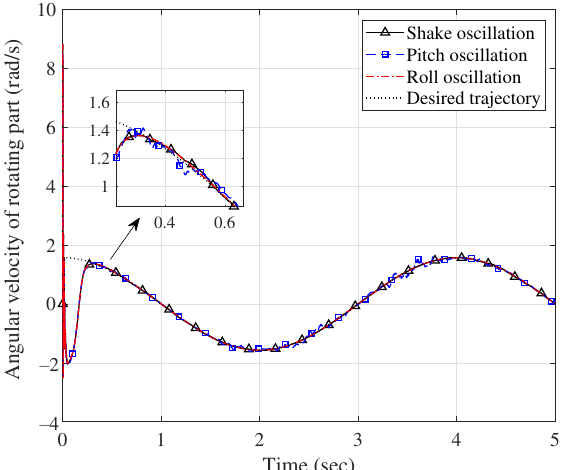
Figure 10. Velocity of lifting part (Group 1).